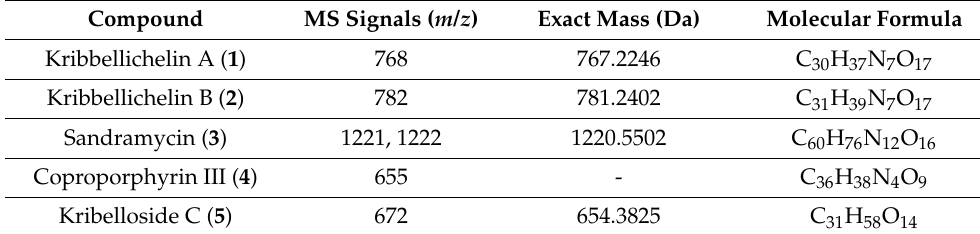
Table 1. Summary of identified active compounds 1 – 5 . Compound MS Signals ( m / z ) Exact Mass (Da) Molecular